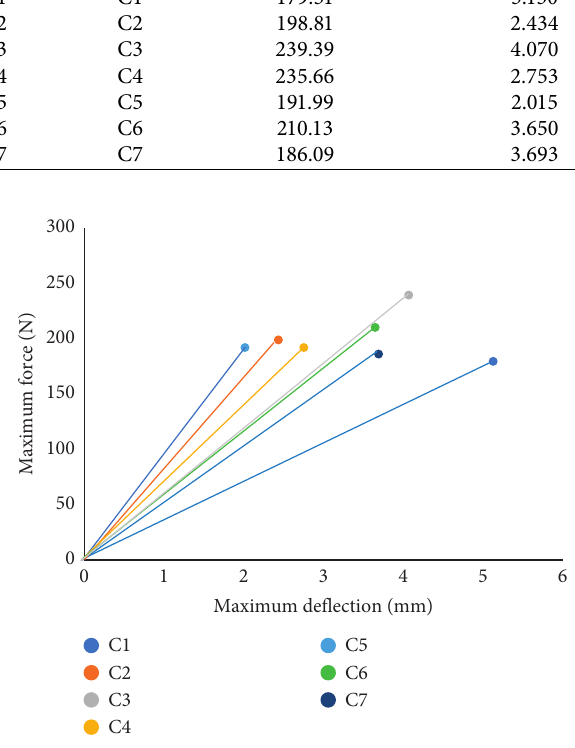
Figure 3: Load versus deflection under flexural loading.